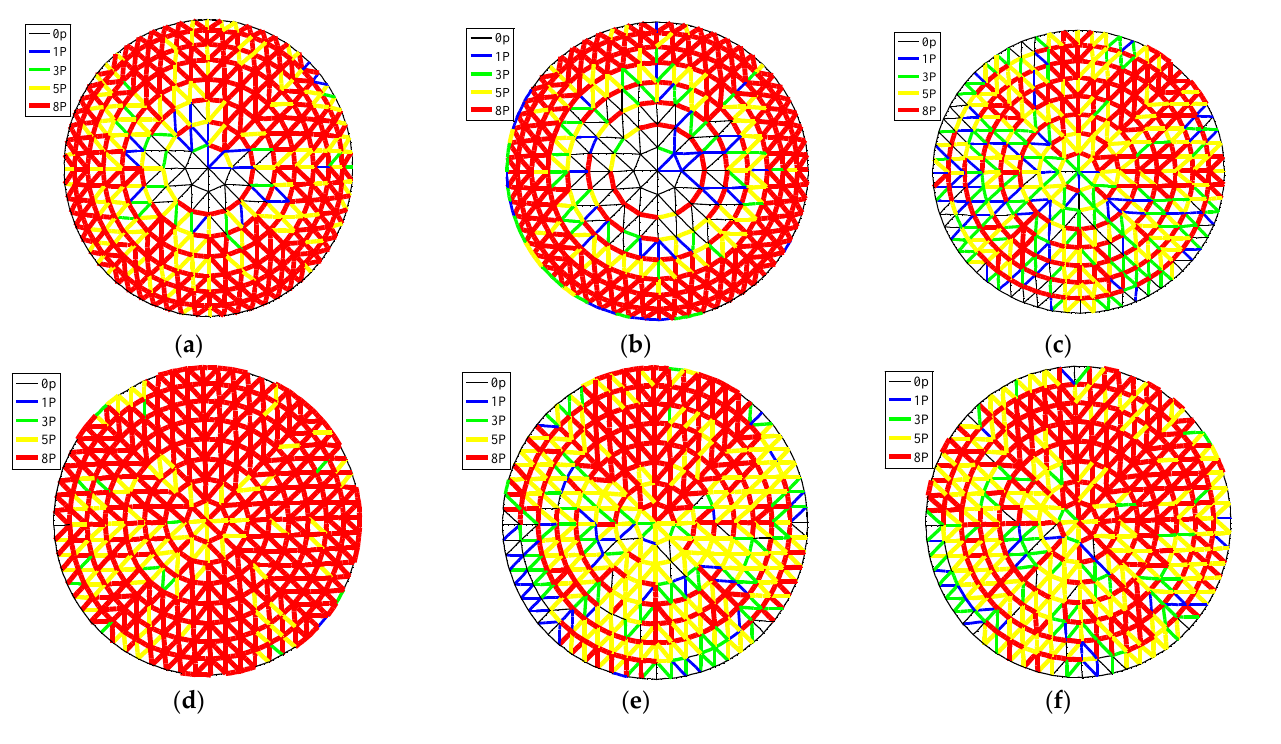
Figure 16. Distributions of plastic members of the shells with different purlin joints ratio: ( a ) D6033-W 1200 cm/s 2 ; ( b ) D6033-HHWM Φ = 4.0 1800 cm/s 2 ; ( c ) D6053-W 1200 cm/s 2 ; ( d ) D6053-HHWM Φ =4.0 2600 cm/s 2 ; ( e ) D6073-W 1500 cm/s 2 ; ( f ) D6073-HHWM Φ =4.0 2100 cm/s 2.